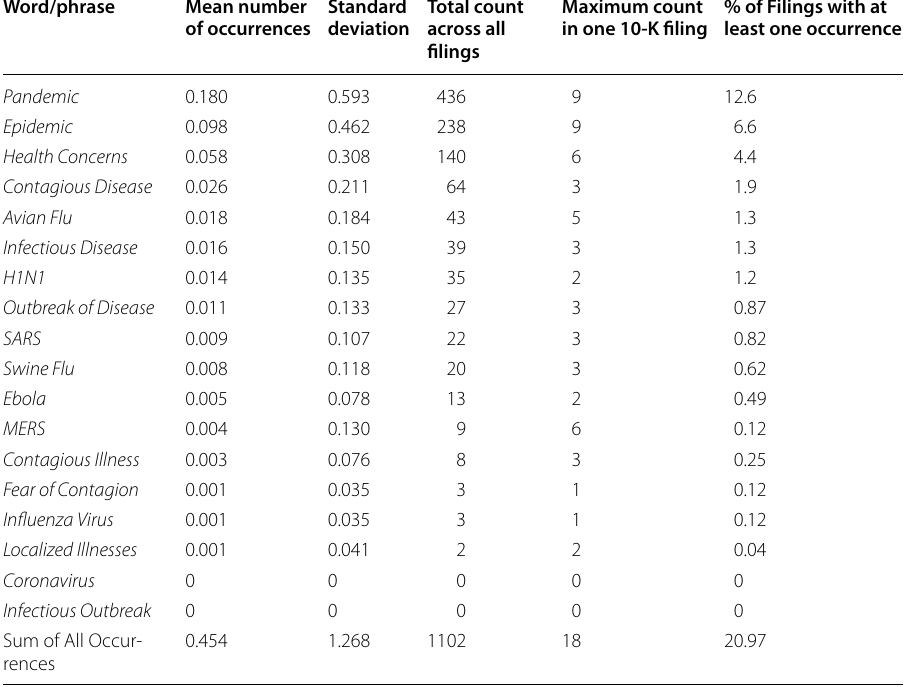
Table 1 Summary statistics for targeted words and phrases for 2427 firm 10-Ks filed in 2018-sorted by total